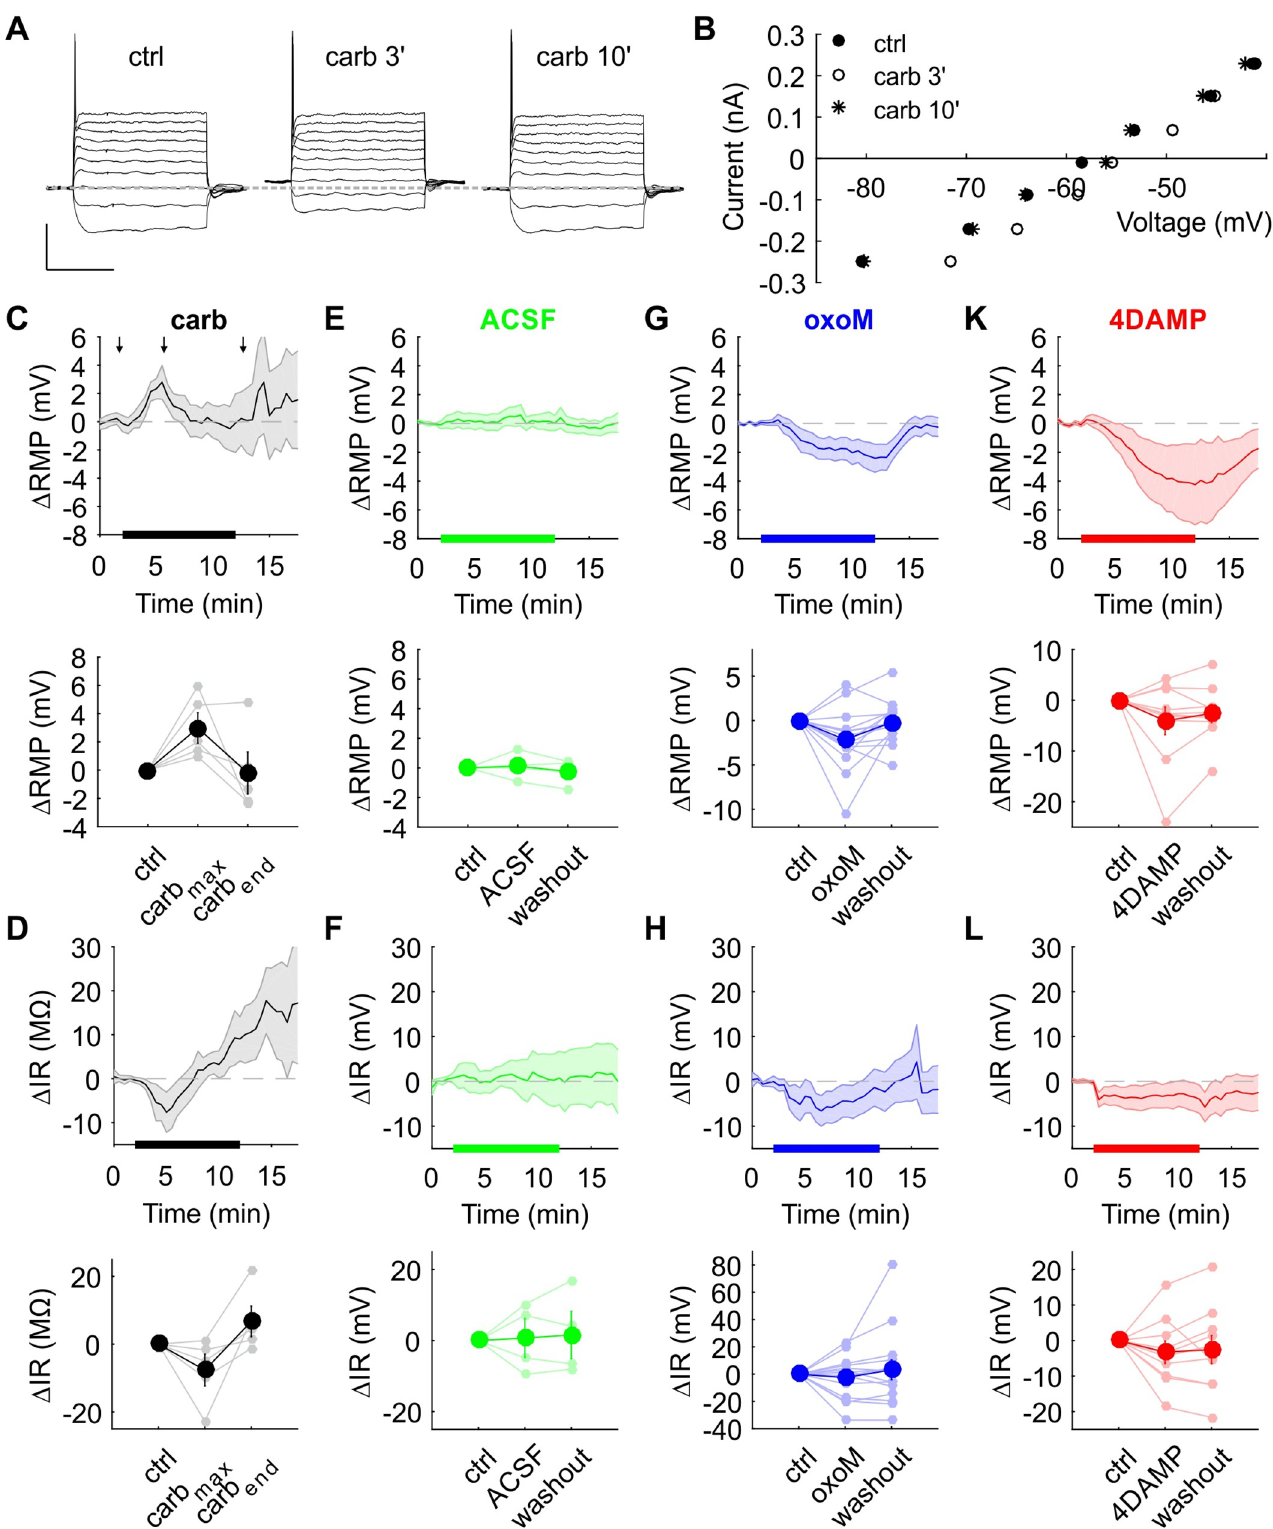
Fig 9. RMP and IR monitoring during application of cholinergic compounds. (A) Voltage response to 10 current step injections in control (left), after 3 min (middle) and 10 min (right) of carbachol perfusion; scale: 200 ms/30 mV. (B) Current-voltage curves of the recordings shown in (A). (C) Mean of RMP change